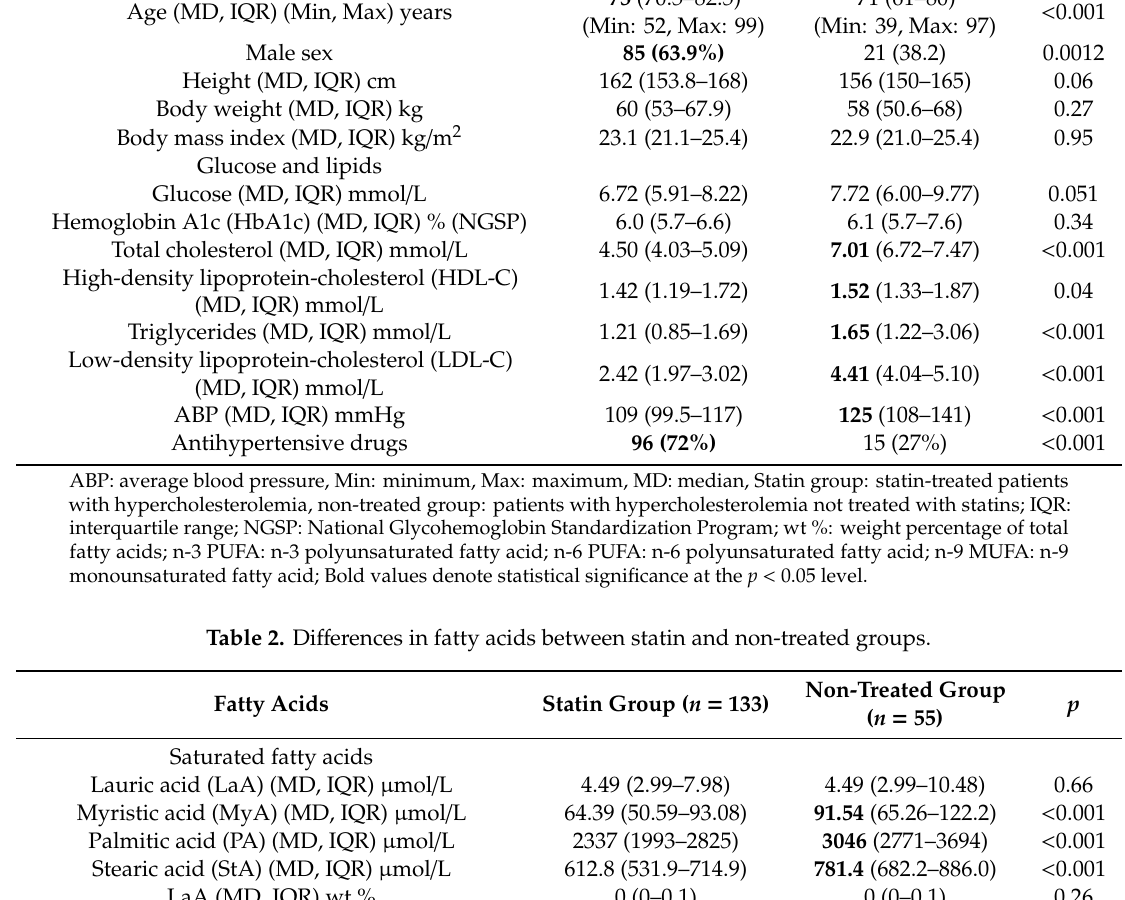
Table 1. Di ff erences in patient characteristics between statin and non-treated groups. Variables